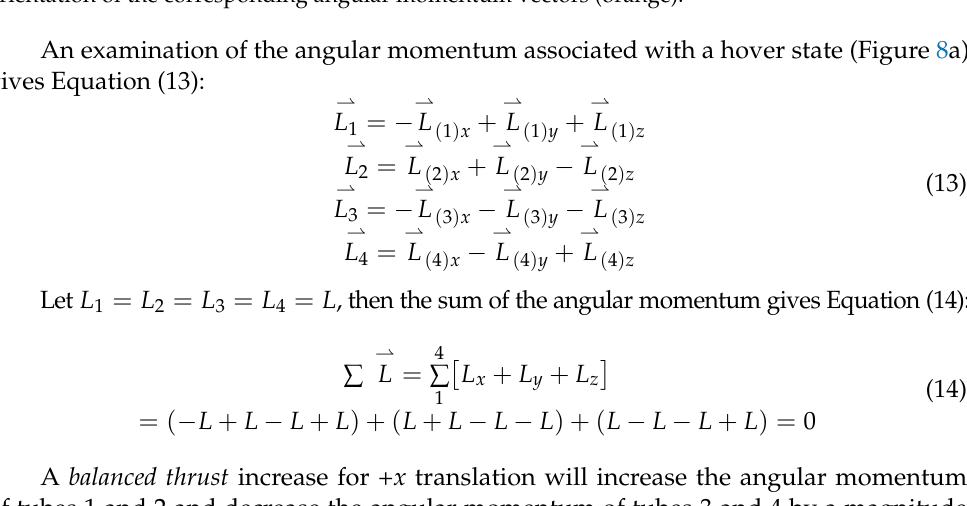
Figure 8. Angular momentum (top view) ( a ) Hover conditions ( b ) Balanced thrust increase for + x translation. Note the thrusters are arranged with counter-rotating spins (yellow arrows), necessary to prevent unintended yaw due to conservation of angular momentum. Additionally, note the orientation of the corresponding angular momentum vectors (orange).